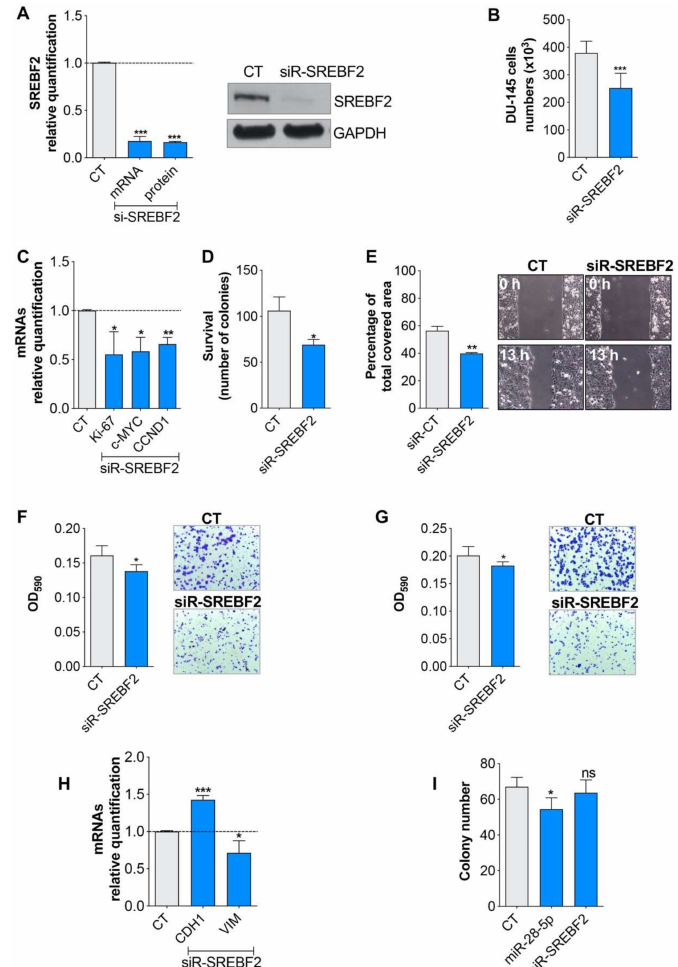
Figure 4. Evaluation of the SREBF2 role in DU-145 PCa cells. ( A ) SREBF2 inhibition by siR-SREBF2 transfection in DU-145 cells analyzed by qRT-PCR and western blot analysis. Evaluation of SREBF2 silencing e ff ect on proliferation ( B ), survival ( D ) migration ( E , F ) and invasion ( G ) in DU-145 cells. Relative expression of proliferation (Ki-67, c-MYC and cyclin D1 (CCND1)) ( C ), epithelial (E-cadherin 1 (CDH1)) and mesenchymal markers (Vimentin (VIM)) ( H ) in miR-28-5p overexpressing versus normal DU-145 cells. ( I ) Number of colonies formed in soft agar in DU-145 cells after miR-28-5p overexpression or SREBF2 silencing. * p < 0.05, ** p < 0.01, *** p < 0.001, unpaired t -test. ns, not